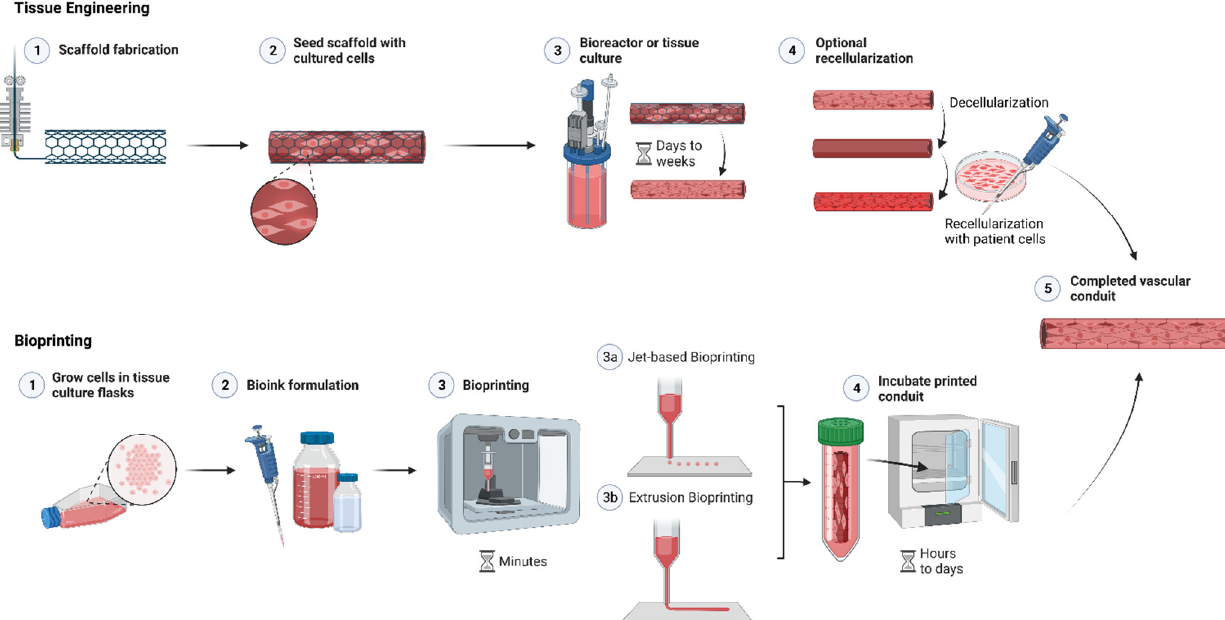
Figure 3. Tissue engineering and bioprinting approaches to creating vascular conduits. Created using BioRender.